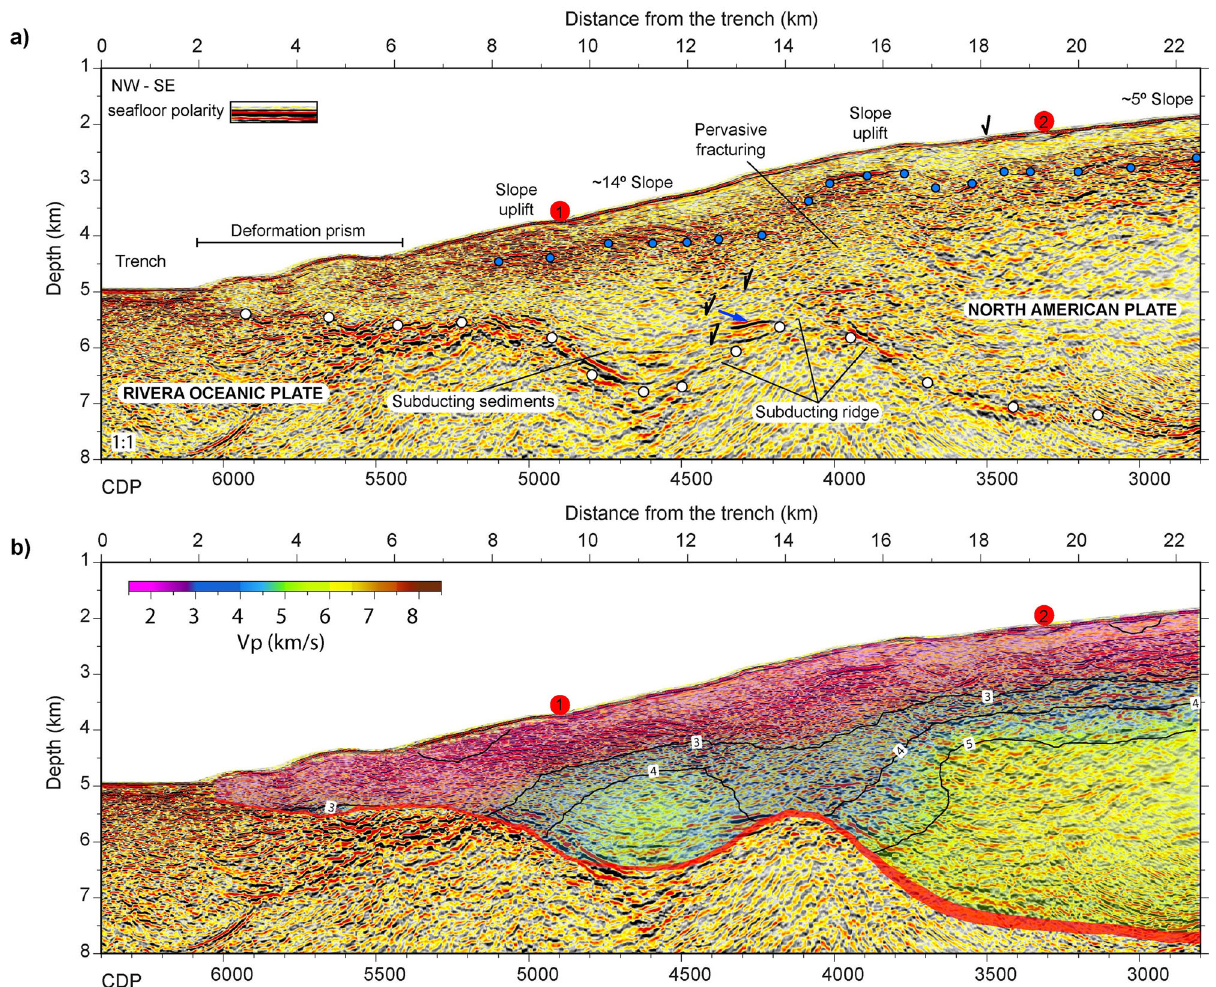
Fig. 3 Correlation between tectonics and velocity structure of the shallow subduction zone. a Pre-stack depth migrated section of pro fi le TS02 showing the geometry of the interplate (white dots), the top of the basement (blue dots), and the presence of the subducting ridge at 14 − 15 km from the trench. Red circles are ocean-bottom seismometers, and the blue arrow points to reverse polarity re fl ectors. Black arrows indicate normal faulting. b Same PSDM section as in ( a ) overlapped with P-wave velocity values from the 2D tomographic model in Fig. 2a. The inverted interplate re fl ector is also included in the fi gure and matches with the location of the interplate interpreted in ( a